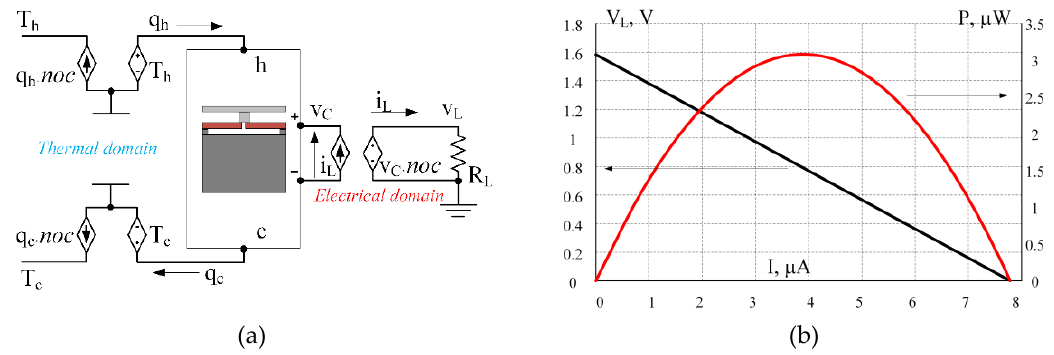
Figure 13. Simulation of a 1k-couples sub-unit using the model of a single couple shown in Figure 11. ( a ) Usage of behavioral voltage and current sources pairs to imitate the series connection of the couples in the electrical domain and parallel connection of the couples in the thermal domain. ( b ) The load curves (V-I and P-I) of the sub-unit with 1k couples.